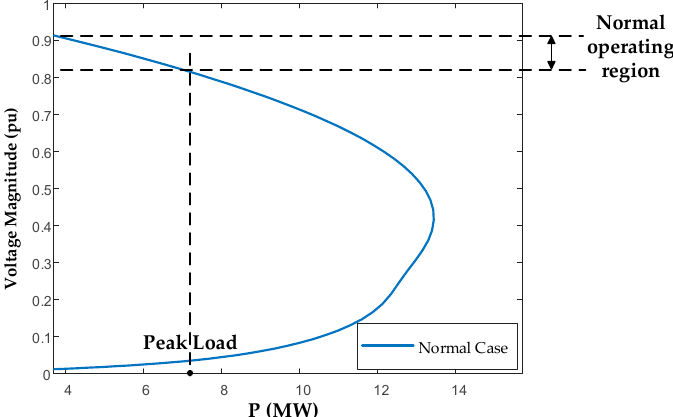
Figure 6. PV curve and peak load around the weakest bus 18.